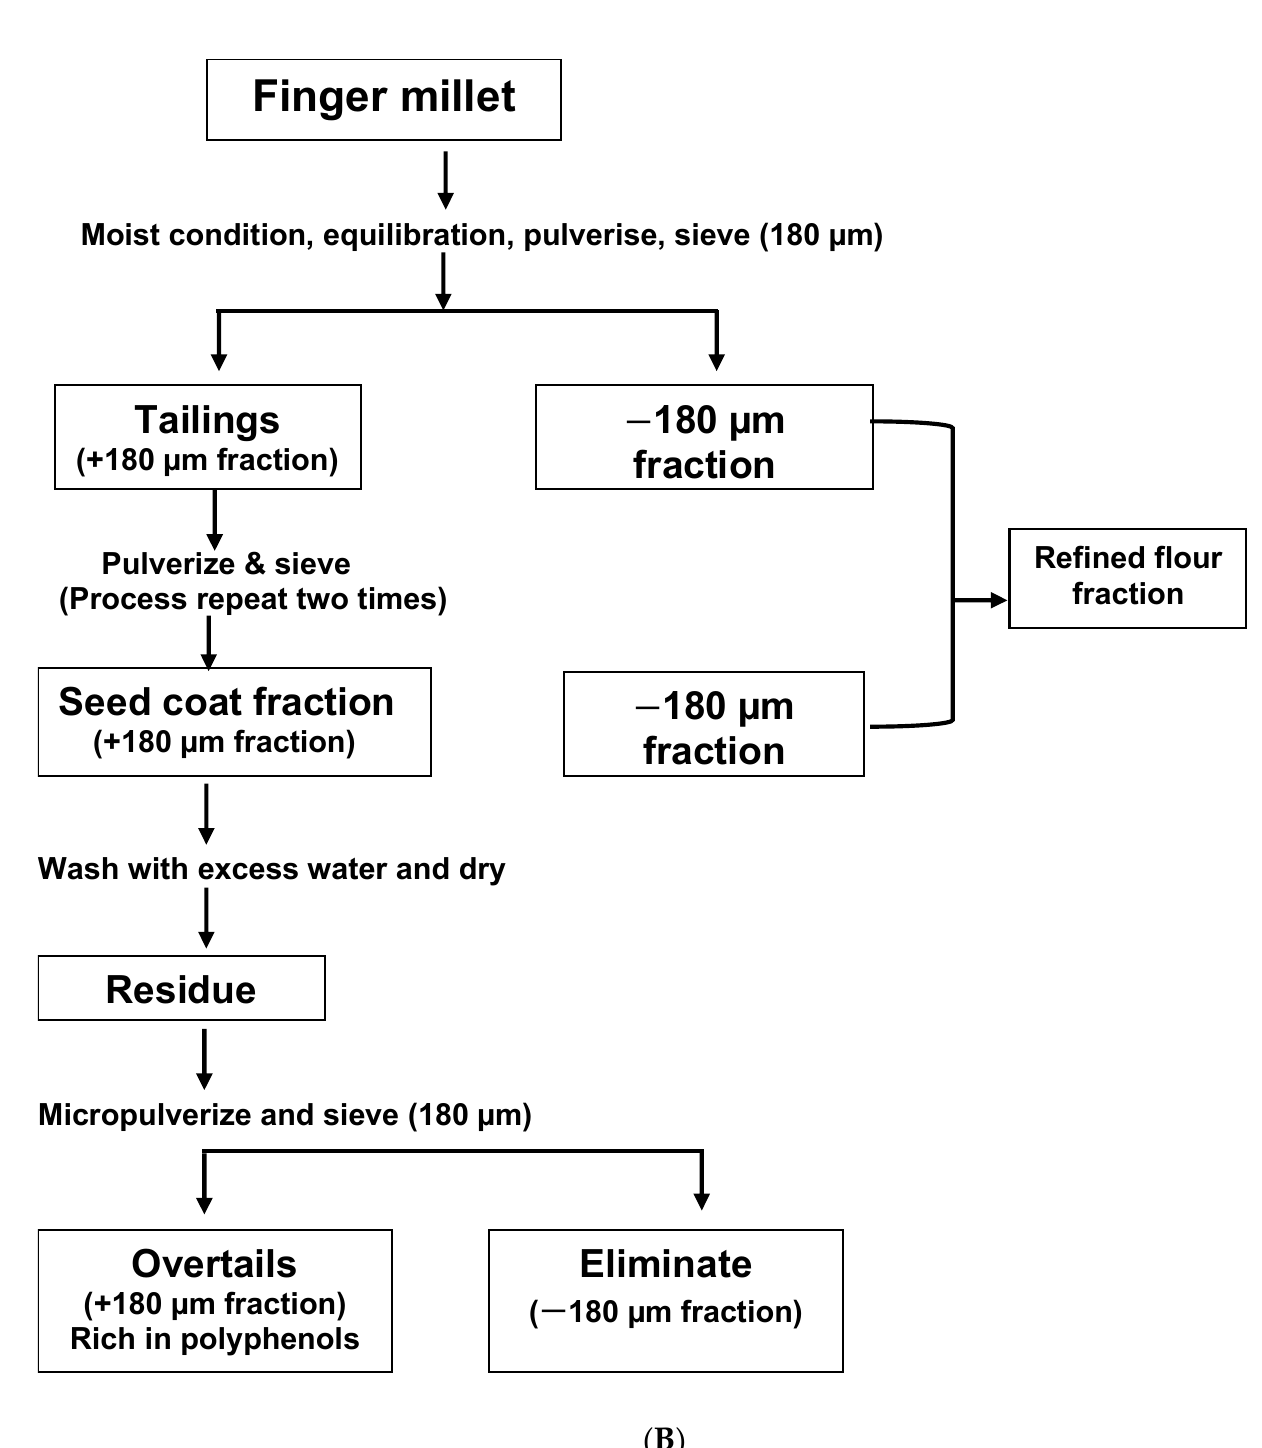
Figure 1. Extraction of finger millet seed coat. ( A ) Malleshi [14]; ( B ) Shobana et al. [15].